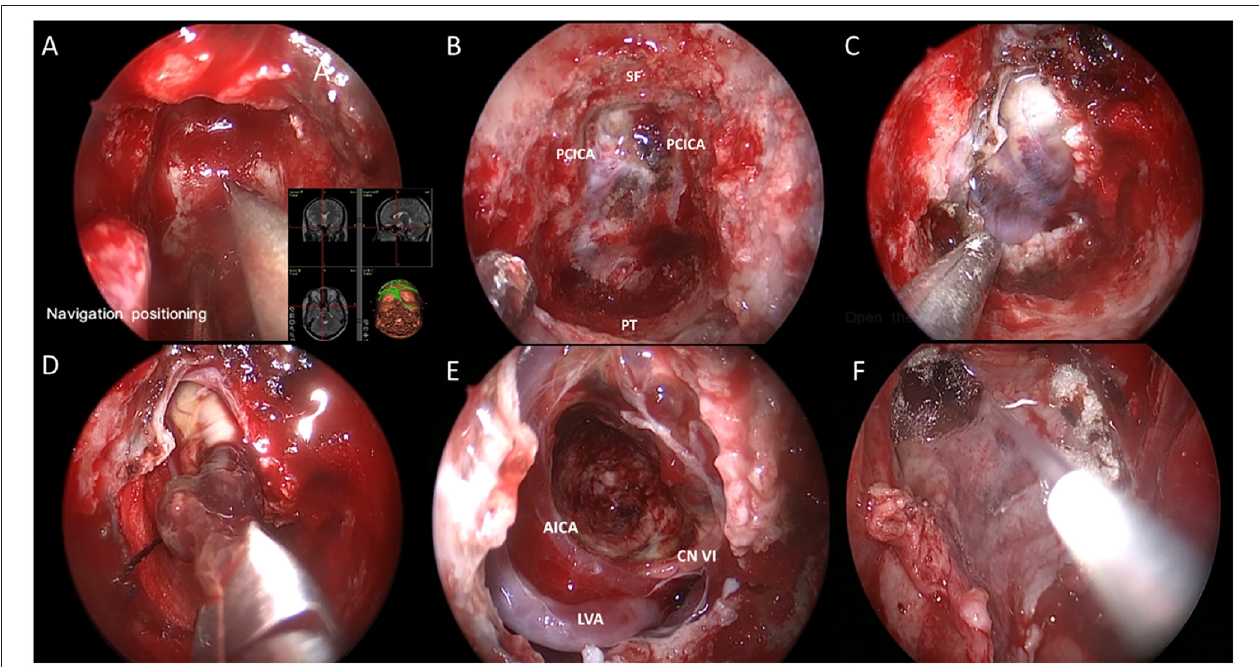
FIGURE 2 | Endoscopic endonasal view of the intraoperative phases. (A) Intraoperative navigation locating surgical boundary; (B) Fully exposure of clivus. SF, PT and PCICA was illustrated; (C) Exposure of tumor after opening dura; (D) Dissection and removal of the cavernous malformation; (E) Intraoperative view through a 0 ◦ endoscope in the cavity; (F) Multi-layer reconstruction of skull base. Labeled structures: AICA, anterior inferior cerebellar artery; LVA, left vertebral artery; CN VI, cranial nerve VI; SF, sellar floor; PCICA, paraclival internal carotid artery; PT, pharyngeal